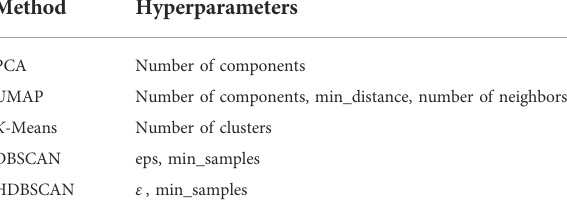
TABLE 1 Dimensionality reduction and clustering methods with their corresponding hyperparameters.